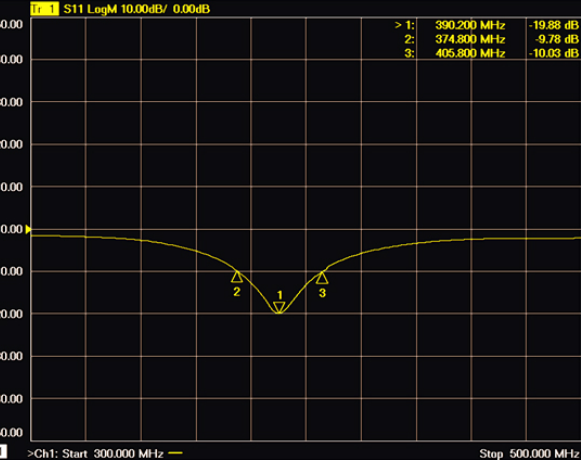
Figure 14. The return loss of the proposed antenna buried in the muscle layer of